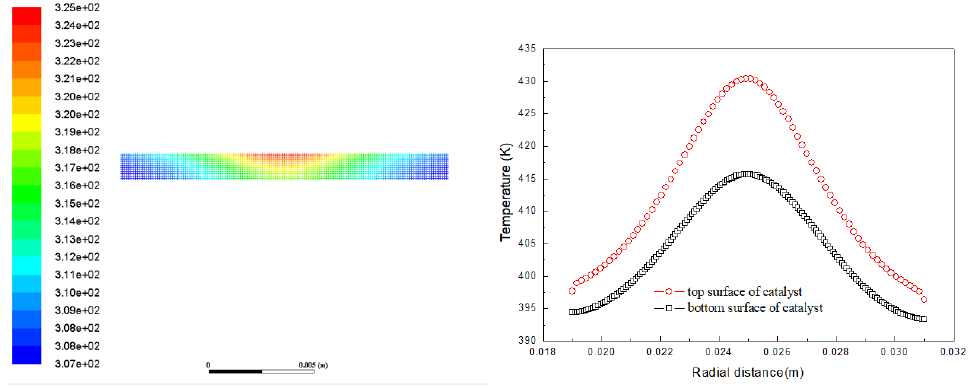
Figure 4. Modeled temperature distribution on the catalyst surface: ( left ) schematic, ( right ) nu- meric.